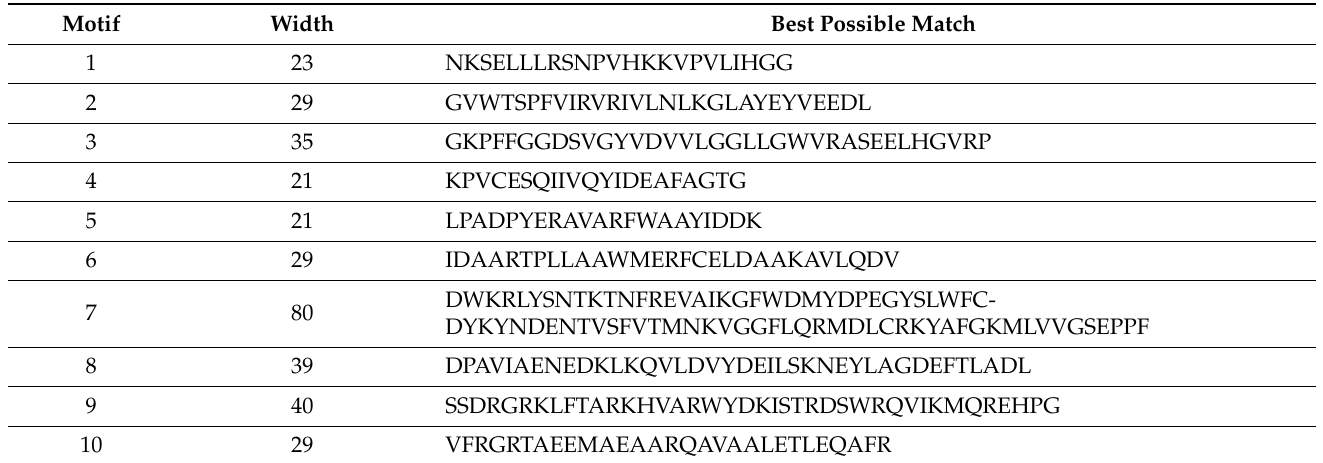
Table 1. List of the putative motifs of ZmGST proteins.